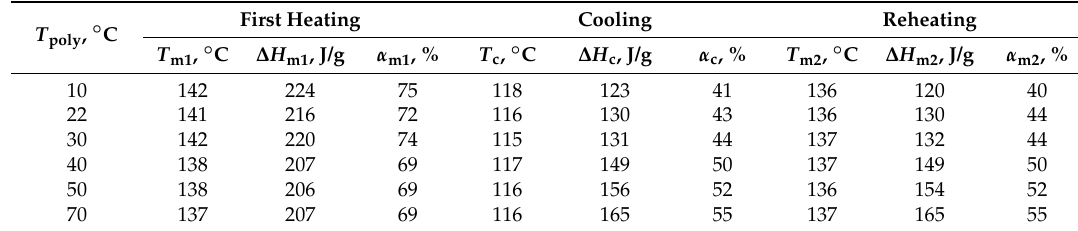
Table 2. DSC data and crystallinity of nascent reactor powders.